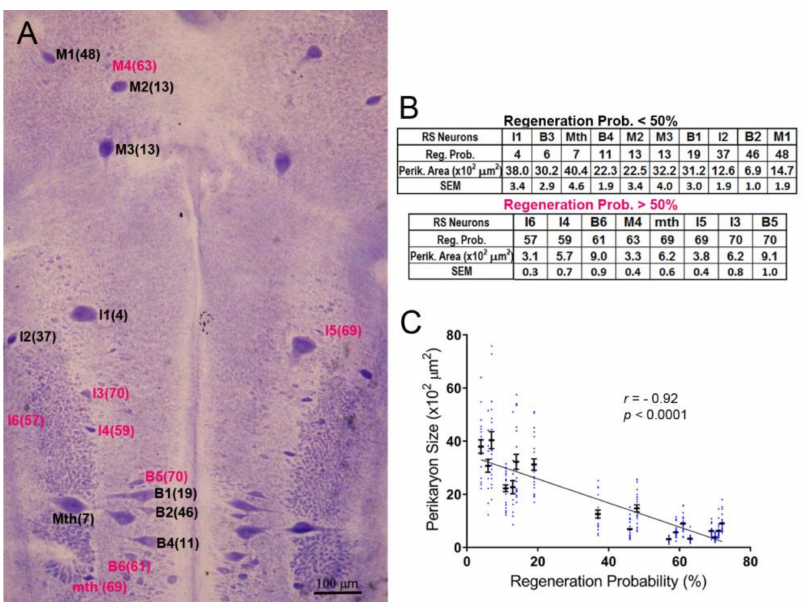
Figure 1. The sizes of identified reticulospinal (RS) neurons correlate inversely with their axon regeneration probabilities. ( A ) Toluidine blue-stained whole-mount of a lamprey brain. The identified RS neurons are labeled, with the % probability that their axon will regenerate by 10 weeks post-TX [13] shown in parentheses. Good regenerators are labeled in black, bad regenerators in red; ( B ) tables listing the probability of regeneration for each of 18 paired, identified RS neurons and their cross-sectional area (mean and SEM) from 11 larval lampreys; ( C ) scatter plot showing that the regenerative probabilities of RS neurons are inversely correlated with their sizes. The neuron names in A and B are according to the nomenclature of Rovainen (1976). B = bulbar group; I = isthmic group; M = mesencephalic group; Mth = Mauthner neuron; mth’ = auxiliary Mauthner